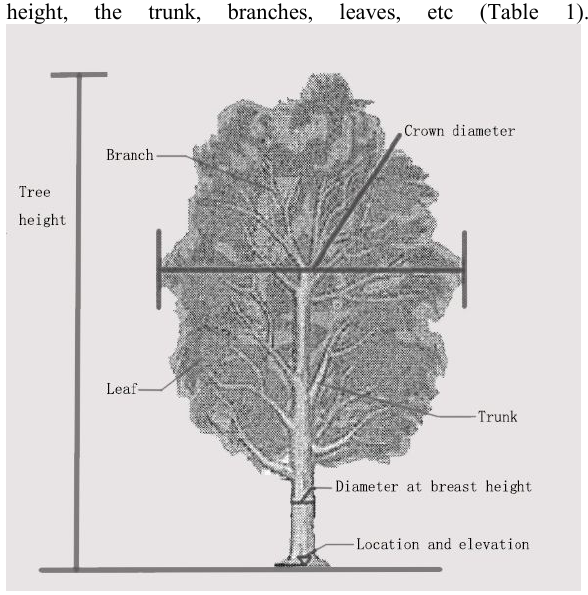
Figure 3. Trees Measurement Standard